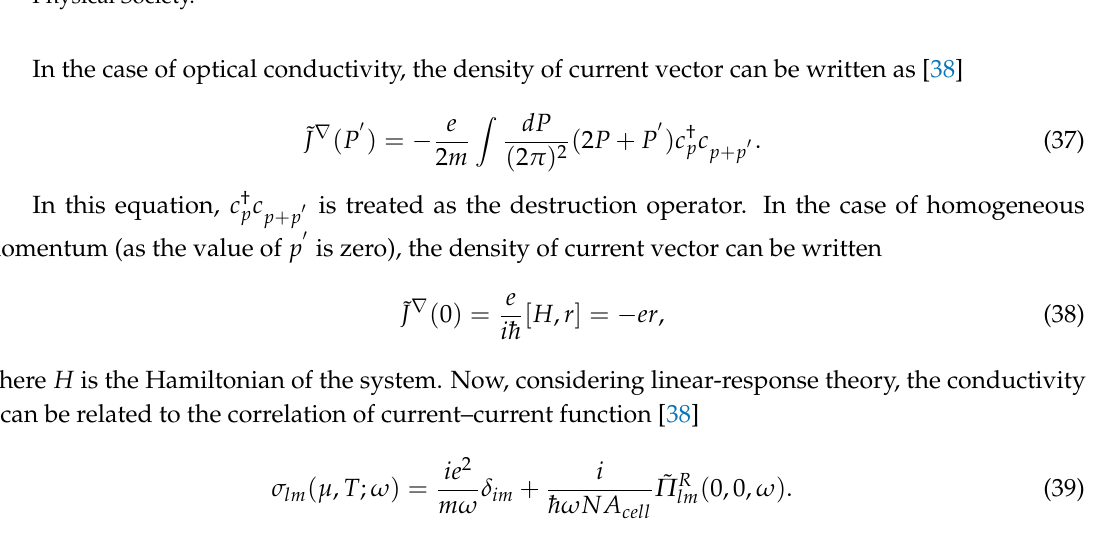
Figure 4. The red color shows the stained and the blue color presents the unstained honeycomb lattice where the value of θ is π /4. Reprinted with permission from [38]. Copyright (2010) American Physical